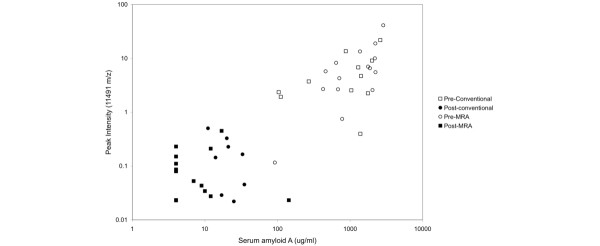
Peak intensities of the 11.6-kDa m/z SELDI peak in serum after MRA treatment in SJIA. The peak intensities correlated with the SAA titers measured by latex agglutination. MRA, humanized anti-IL-6 receptor monoclonal antibody; SAA, serum amyloid A; SELDI, surface-enhanced laser desorption SJIA, systemic juvenile idiopathic arthritis.